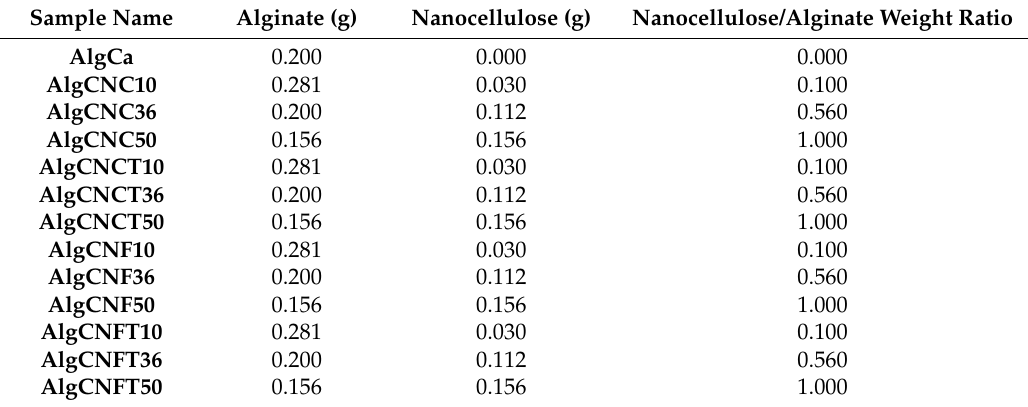
Table 1. Composition of the reagents used in the nanocellulose-alginate gels